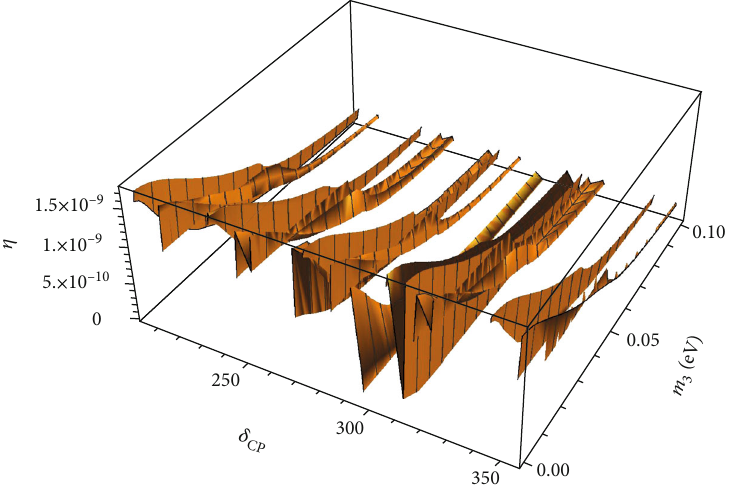
Figure 4: Predictions in the broken μ − τ symmetry model for inverted ordering: three-dimensional plot for predicted favoured values of the ð m , δ , η Þ plane for the best fi t values of θ = 8 : 49 ° of Δχ 2 = 9 : 5 w/o SK-ATM [14] (in the light of recent ratio of the baryon to photon 3 CP 13 density bounds, 5 : 8 × 10 − 10 < η < 6 : 6 × 10 − 10 ) as a result of contribution of the type I seesaw mechanism to neutrino mass